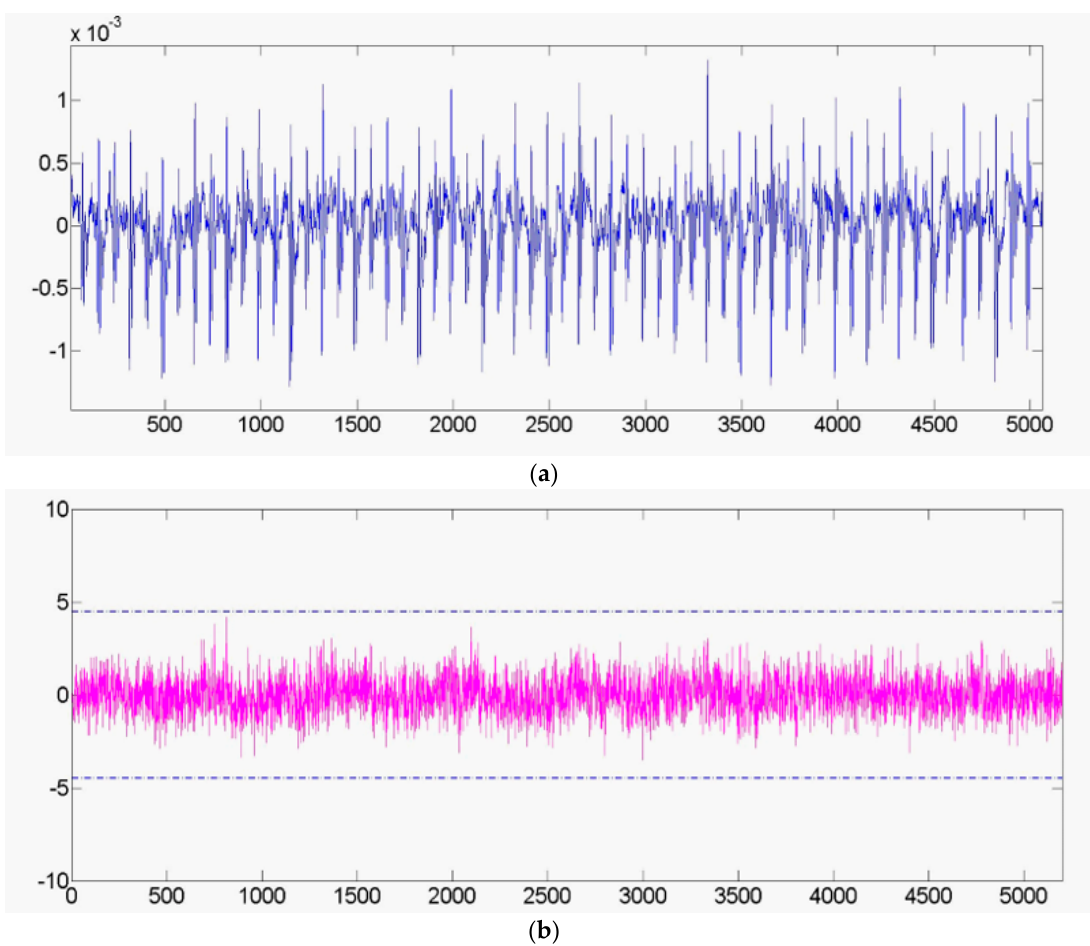
Figure 14. ( a ) The power trace of the optimized SIMON 32/64. ( b ) The t -test result of the Figure 14. (a) The power trace of the optimized SIMON 32/64. (b) The t-test result of the optimized optimized circuit.